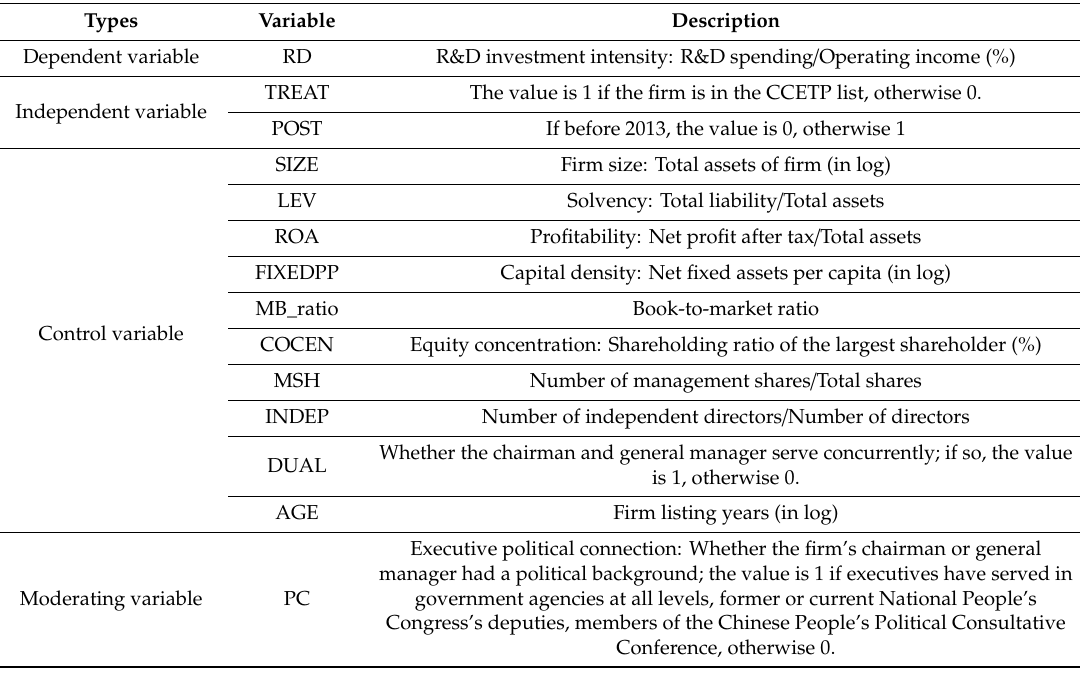
Table 1. Definition and description of main